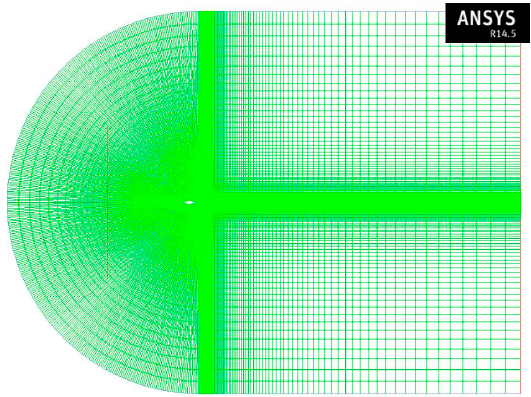
Figure 2. The minimum distance upstream of the airfoil where the particles are tracked.